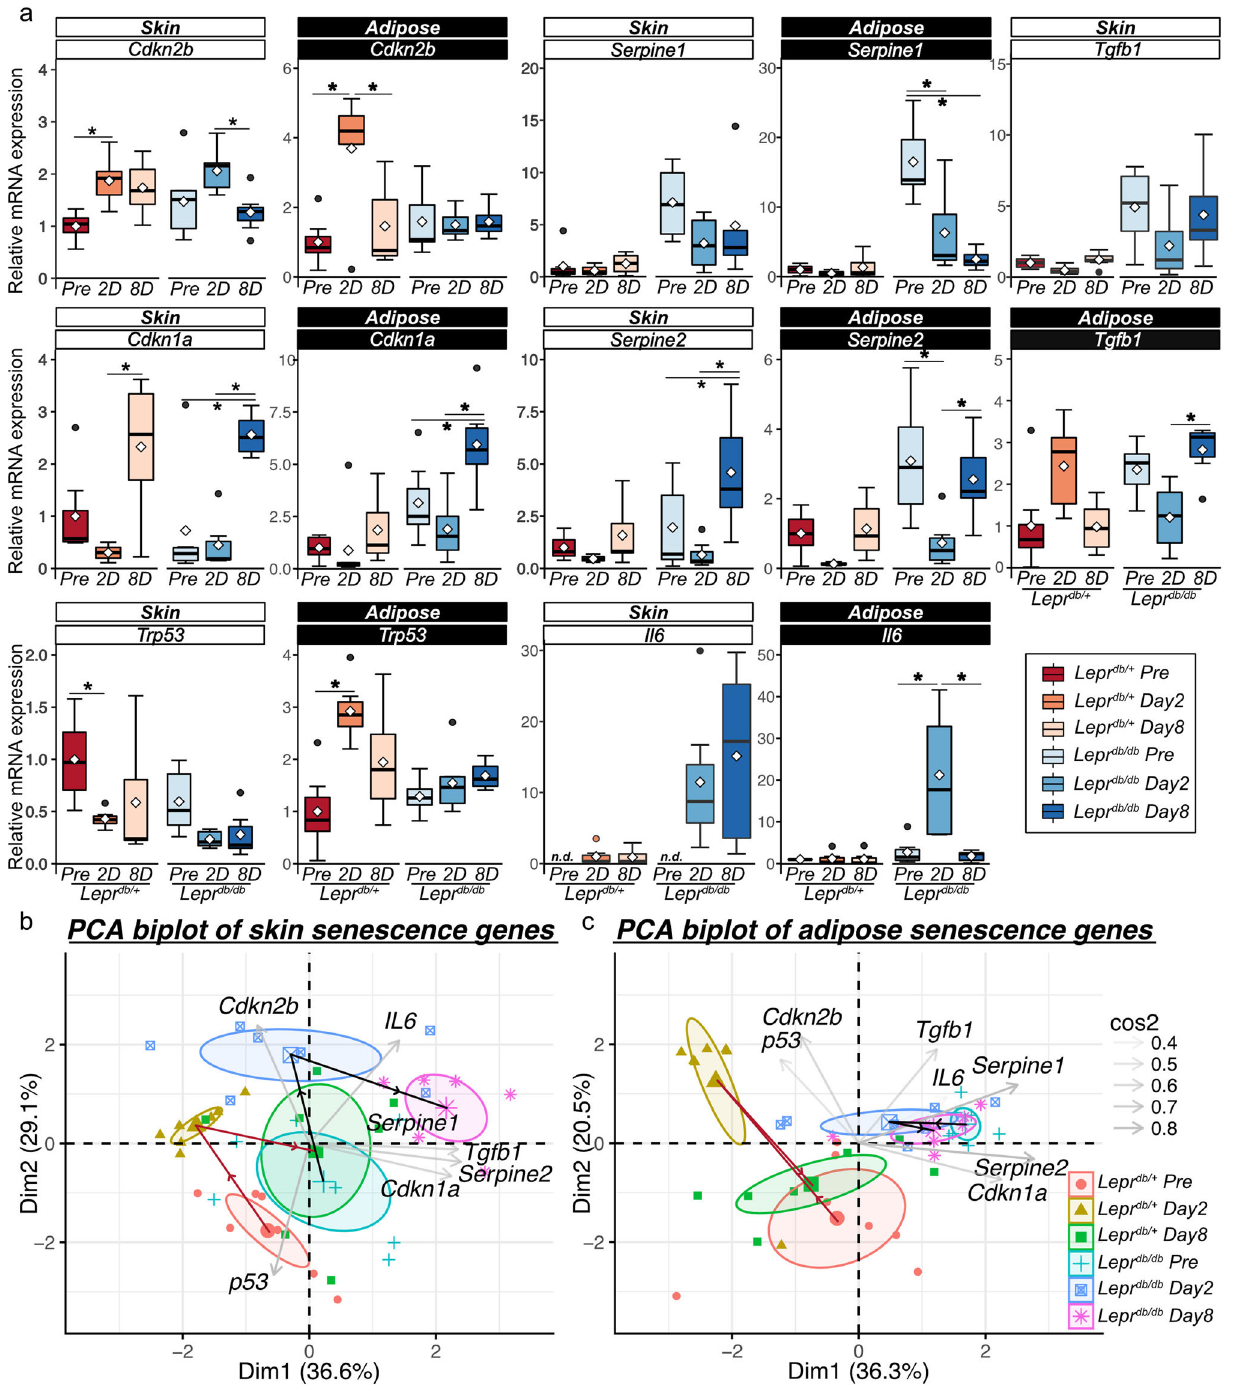
Fig. 3 Cellular senescence in subcutaneous adipose tissue during wound healing in Lepr db/ + and Lepr db/db mice. a Relative mRNA expression of senescence-related genes at pre-wound, 2 DPW, and 8 DPW in Lepr db/ + and Lepr db/db mice ( n = 7 for each group). b, c Principal component analysis (PCA) of the levels of senescence based on senescence-related gene expression at pre-wound, 2 DPW, and 8 DPW for Lepr db/ + and Lepr db/db mice in skin and adipose tissue. Quantitative data are presented as means and medians with IQRs and 1.5 times the IQR and are shown as box-and-whisker plots. p - values were determined using the Tukey method for one-way ANOVA (* p <